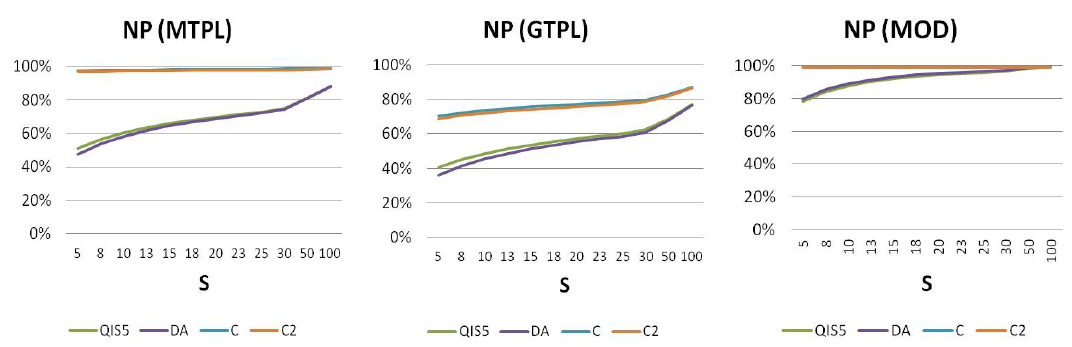
Figure 6. NP LoB according to different retention limits ( L LoB = E ( Z gross